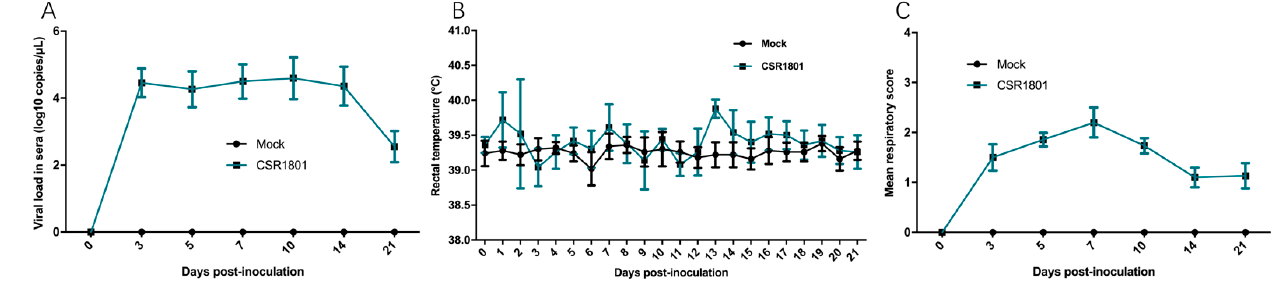
Figure 3. Virus load in the peripheral blood, rectal temperature, and respiratory score. The piglets in group 1 ( n = 5) were all nasally inoculated with 2 mL/pig of the PRRSV CSR1801 strain at a dose of 1 × 10 5 TCID 50 . The piglets in group 2 ( n = 5) were inoculated with the cell culture medium as the mock ‐ inoculated control. ( A ) The virus amounts in sera collected at serial timepoints (0, 3, 5, 7, 10, 14, and 21 dpi) from the CSR1801 ‐ inoculated and mock ‐ inoculated piglets. The data represent the mean values (±SD) of the log10 virus copies/mL determined by conducting absolute RT ‐ qPCR. ( B ) Rectal temperature changes in piglets after virus infection. The daily average temperatures of the animals in the group infected with the CSR1801 strain and the mock group piglets are shown. ( C ) Mean respiratory score from the CSR1801 ‐ inoculated and the mock ‐ inoculated piglets at serial timepoints (0, 3, 5, 7, 10, 14, and 21 dpi). Each point represents the mean values (±SD) generated from all the pigs at 0–21 dpi. In general, the piglets inoculated with the PRRSV CSR1801 isolate showed mild clin ‐ ical signs. In the animal challenge experiment, the rectal temperature of piglets inoculated with PRRSV CSR1801 strain increased to 39.7 °C at two dpi and it always fluctuated around 39.5 °C the rest of the time. The rectal temperature of the mock ‐ inoculated pigs